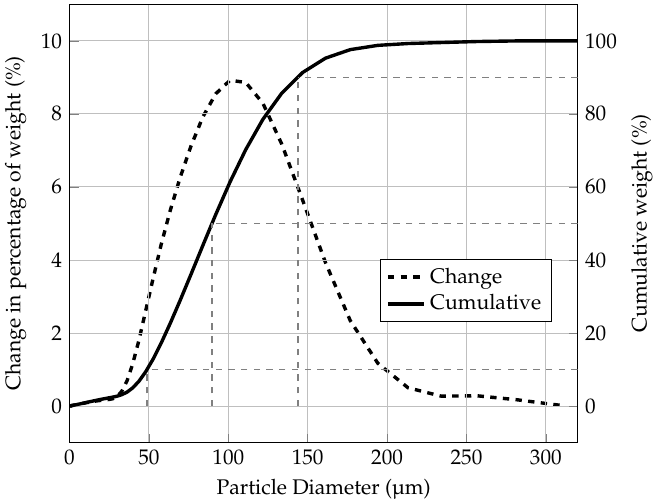
Figure 2. W722 particle size distribution obtained through dynamic light